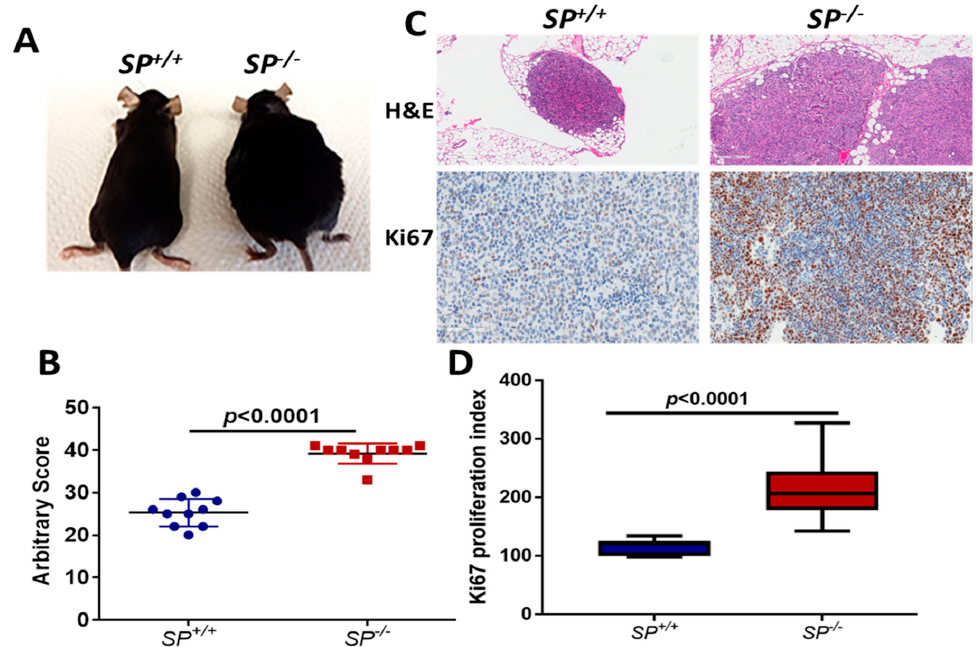
Figure 1. Enhanced growth of ID8 syngeneic tumors in SP − / − mice. ( A ) photomicrographs of SP +/+ and SP − / − mice 8 weeks after ip injection of ID8 cells. ( B ) Scatter plots showing the arbitrary scores of tumor burden in SP +/+ and SP − / − mice. ( C ) H&E staining of ip tumors (100×, upper), Ki67 immunostaining of syngeneic tumor sections (lower, 200×). ( D ) Box plots of the proliferation index determined by counting Ki67 positive nuclei in five random fields/tumor section (n = 3 sections/genotype). p values are determined by Mann-Whitney and Student’s t -test.